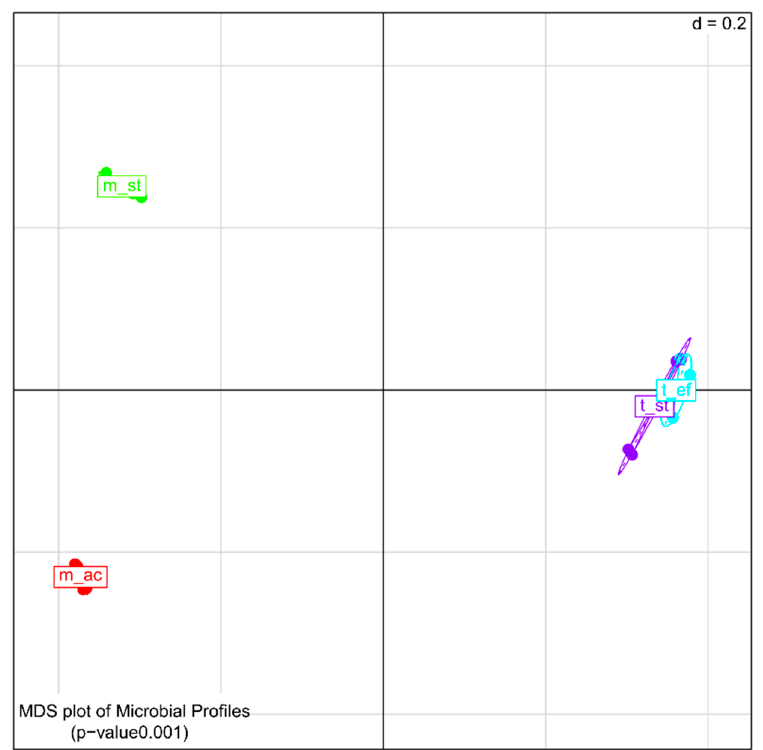
Figure 4. Multi-dimensional scattering (MDS) of the β –diversity of the microbial profiles derived from 16S rDNA and reverse transcribed 16S rRNA amplicon sequences of biogas reactors under four different process conditions with two biological replicates. Samples were grouped for process condition: m_st, mesophilic (38 °C), stable; m_ac, mesophilic, acidified; t_st, thermophilic (50 °C), stable; t_ef, thermophilic, highly efficient.